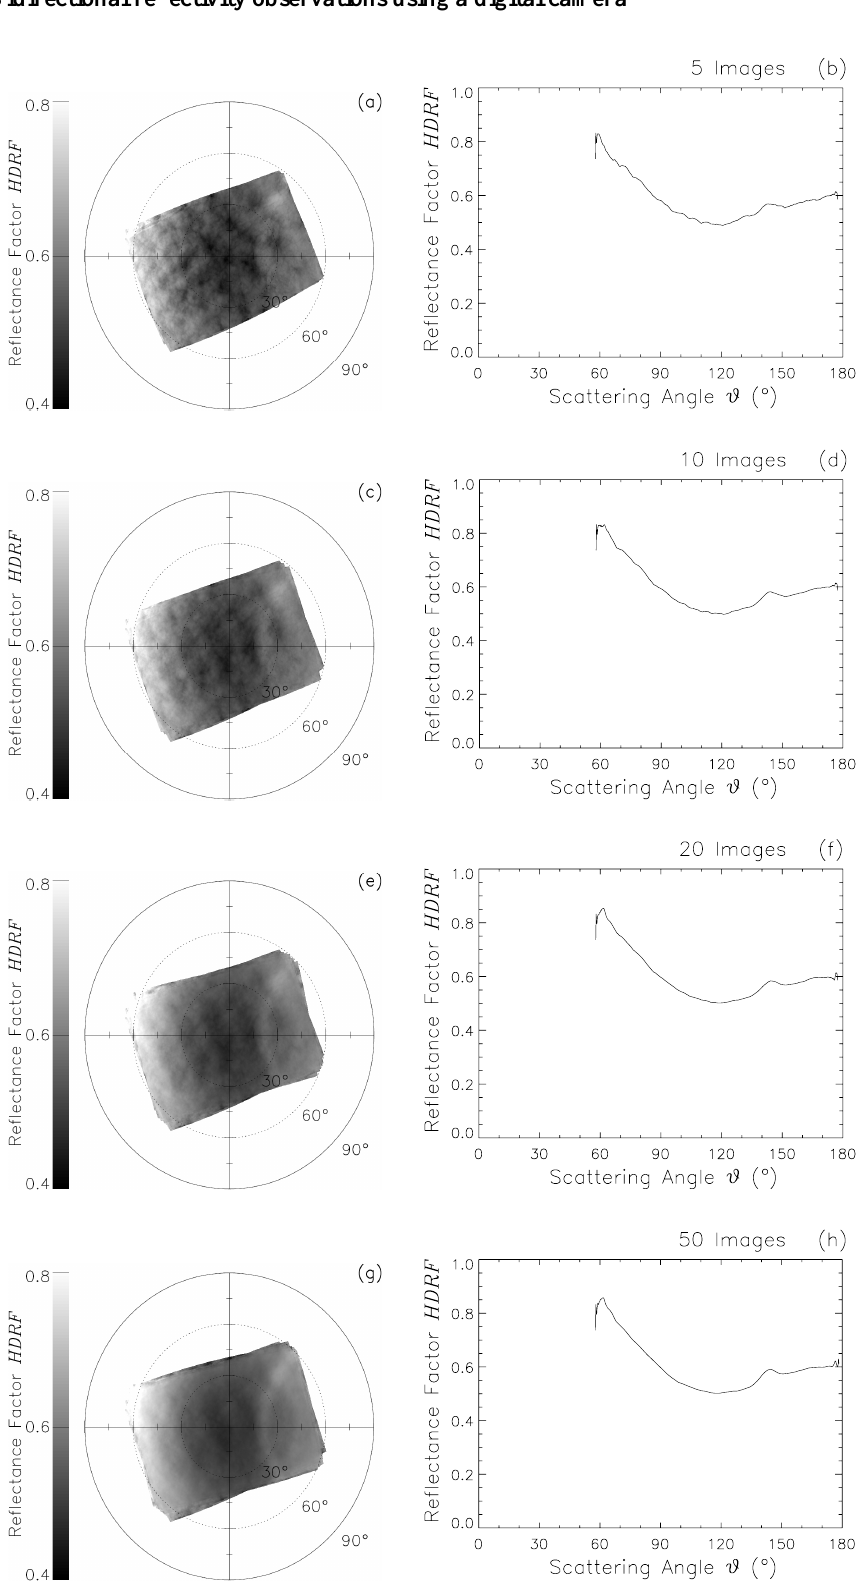
Fig. 8. Average HDRF above clouds (channel 2) calculated from 5, 10, 20, and 50 individual images (a, c, e, g) . The right panels (b, d, f, h) show the corresponding HDRF (ϑ) as function of the scattering